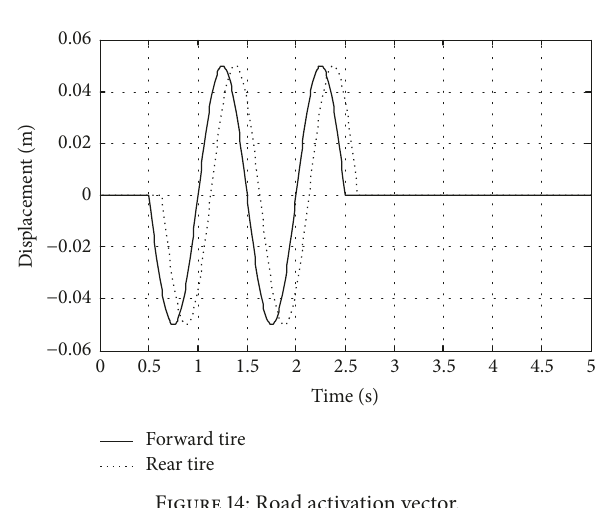
Figure 14: Road activation